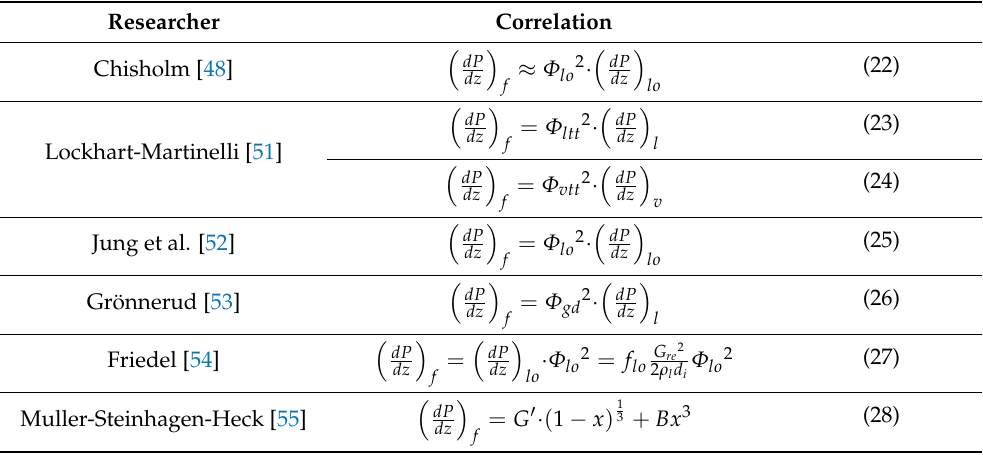
Table 11. Correlations for pressure drop obtained by several